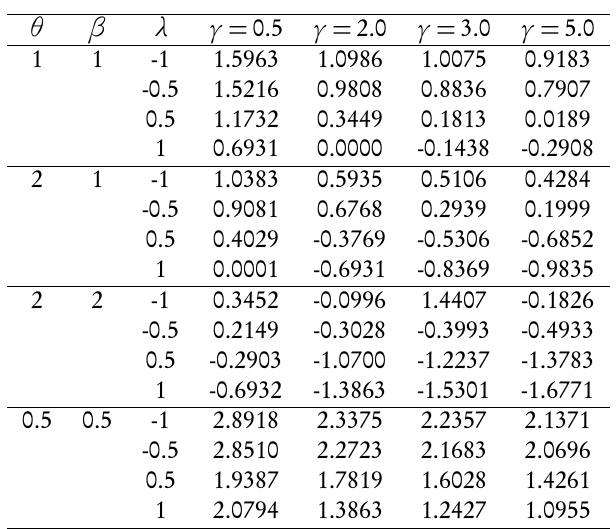
Rényi entropy for given values of θ , β , λ and γ